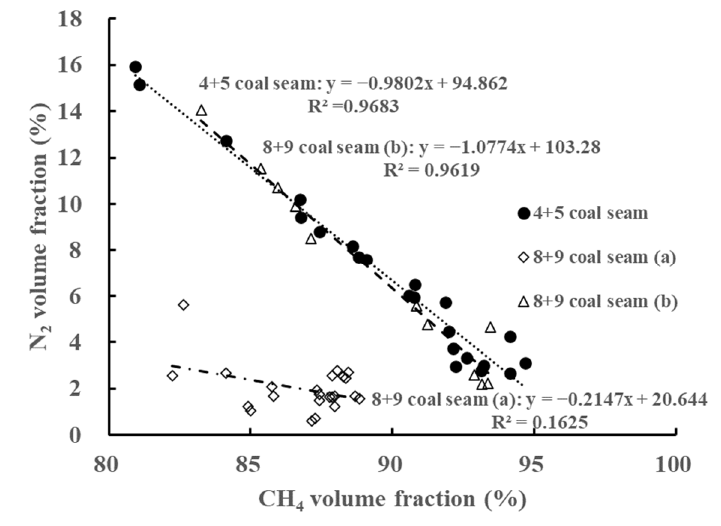
Figure 4. Relationship between N 2 volume fraction and CH 4 volume fraction.